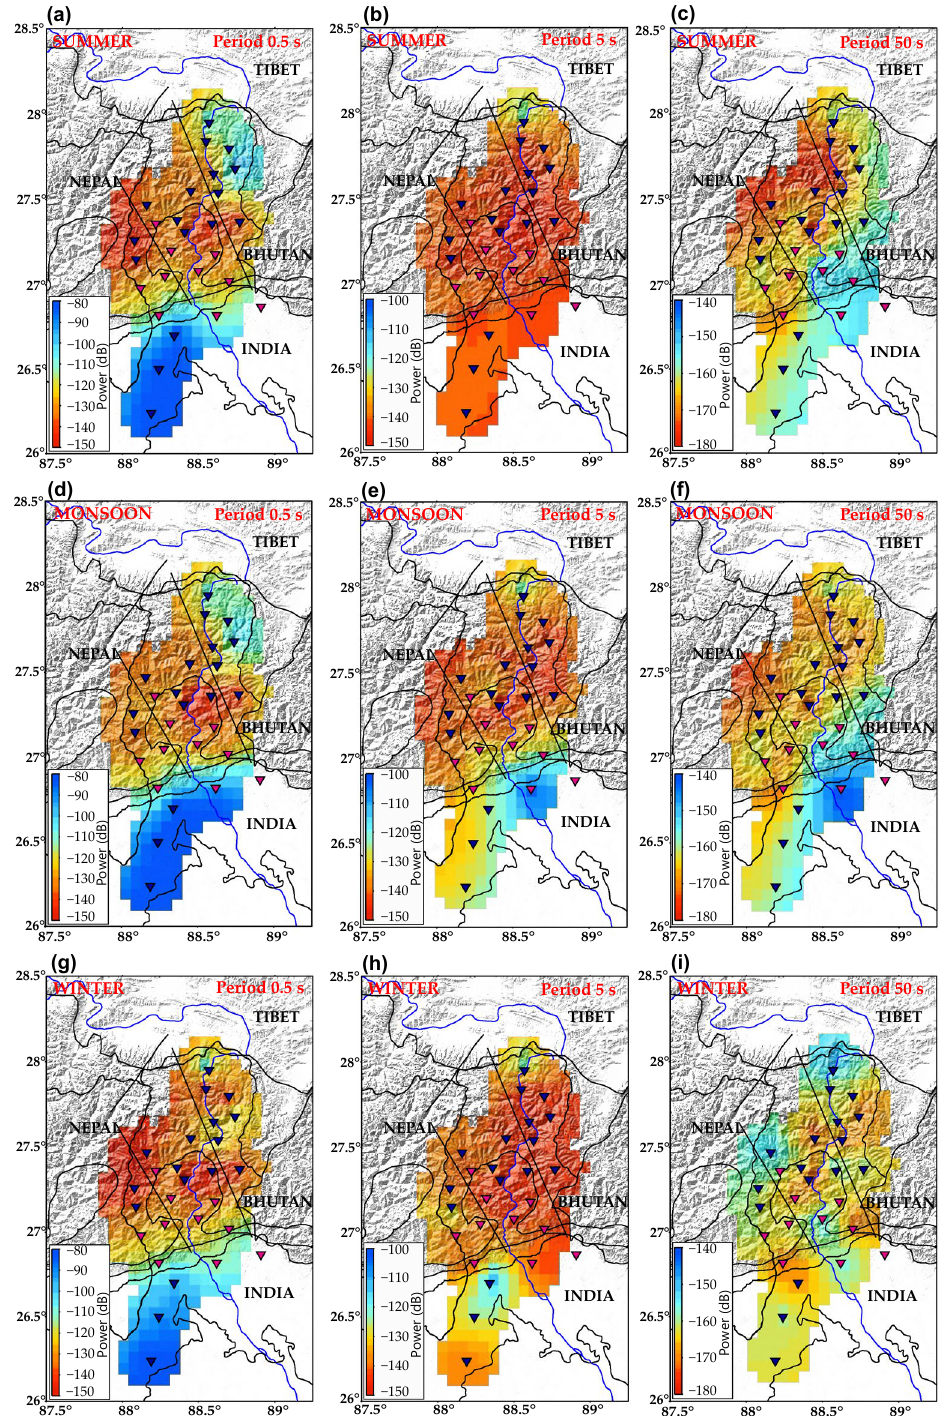
Figure 8. Representation of the median Power Spectral Density (PSD) values of the ambient noise recorded by the vertical component at three periods (0.4 s, 4 s and 40 s) for summer, monsoon and winter season to study seasonal variations in noise levels. ( a ), ( d ), ( g ) Noise level for summer (March-June) at three defined periods. ( b ), ( e ), ( h ) Noise level for monsoon (July-September) at three defined periods. ( c ), ( f ), ( i ) Noise level for winter (November-February) at three defined periods. The colour scales in each sub-figure, ( a – i ) representing PSD (dB), are different for each period to highlight the seasonal variations of the ambient noise levels across the study area. Stations with sensors installed on pier are represented with pink inverted triangles and stations with sensors buried are represented in blue inverted triangles. MFT: Main Frontal Thrust, MBT: Main Boundary Thrust, MCT: Main Central Thrust. Software used to generate the figure: Generic Mapping Tools (GMT) v6.0.0 40